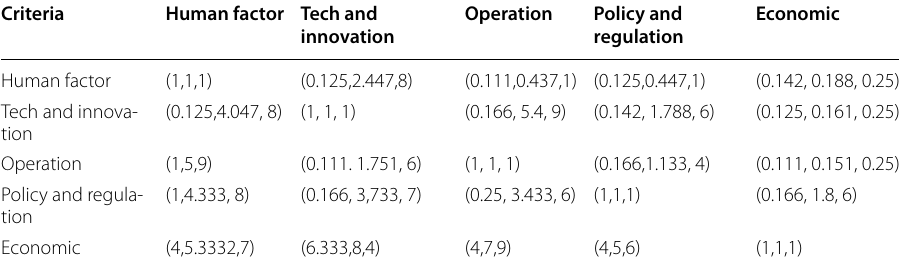
Table 11 Value of geometric mean ( Ƒ ) for all disciplines Human factor